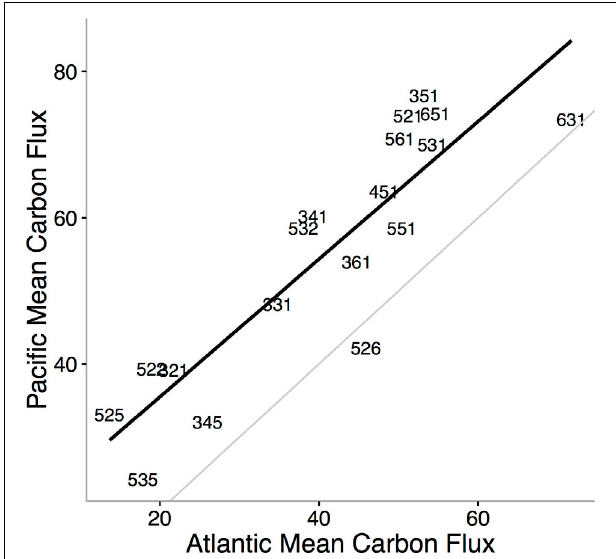
FIGURE 4 | Mean carbon flux of bivalve ecological modes in the Pacific Ocean versus the mean carbon flux of ecological modes in the Atlantic Ocean. Black line denotes the rank order correlation and the gray line represents the one-to-one value line. Numbers refer to unique functional combinations on three ecological mode axes: tiering, motility, and feeding. Each axis consists of six categorical states. The tiering axis consists of 1 pelagic, 2 erect, 3 surficial, 4 semi-infaunal, 5 shallow infaunal, and 6 deep infaunal. The motility axis consists of 1 freely motile/fast; 2 freely motile/slow; 3 facultatively motile/unattached; 4 facultatively motile/attached; 5 non-motile/unattached; and6 non-motile/attached. The feeding axis consists of 1 suspension feeding, 2 surficial deposit feeding, 3 mining, 4 grazing, 5 predatory, and 6 other (for feeding strategies that do not fit into the previous five feeding modes). Using independent values of mean carbon flux for ecological modes by restricting the analysis to species endemic to either the Atlantic or the Pacific, we find striking consistency in the ranking of carbon flux requirements in bivalve ecological modes. The finding that most ecological modes are typically associated with higher flux values in the Pacific Ocean is not surprising; the Pacific is on average more productive than the Atlantic (Marra et al., 1987; Lutz et al., 2007). From McClain et al. (2018).